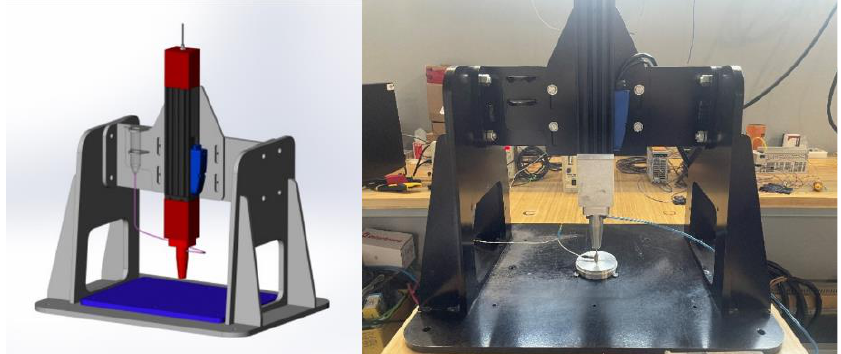
Figure 3. Test stand for servo-driven injector.